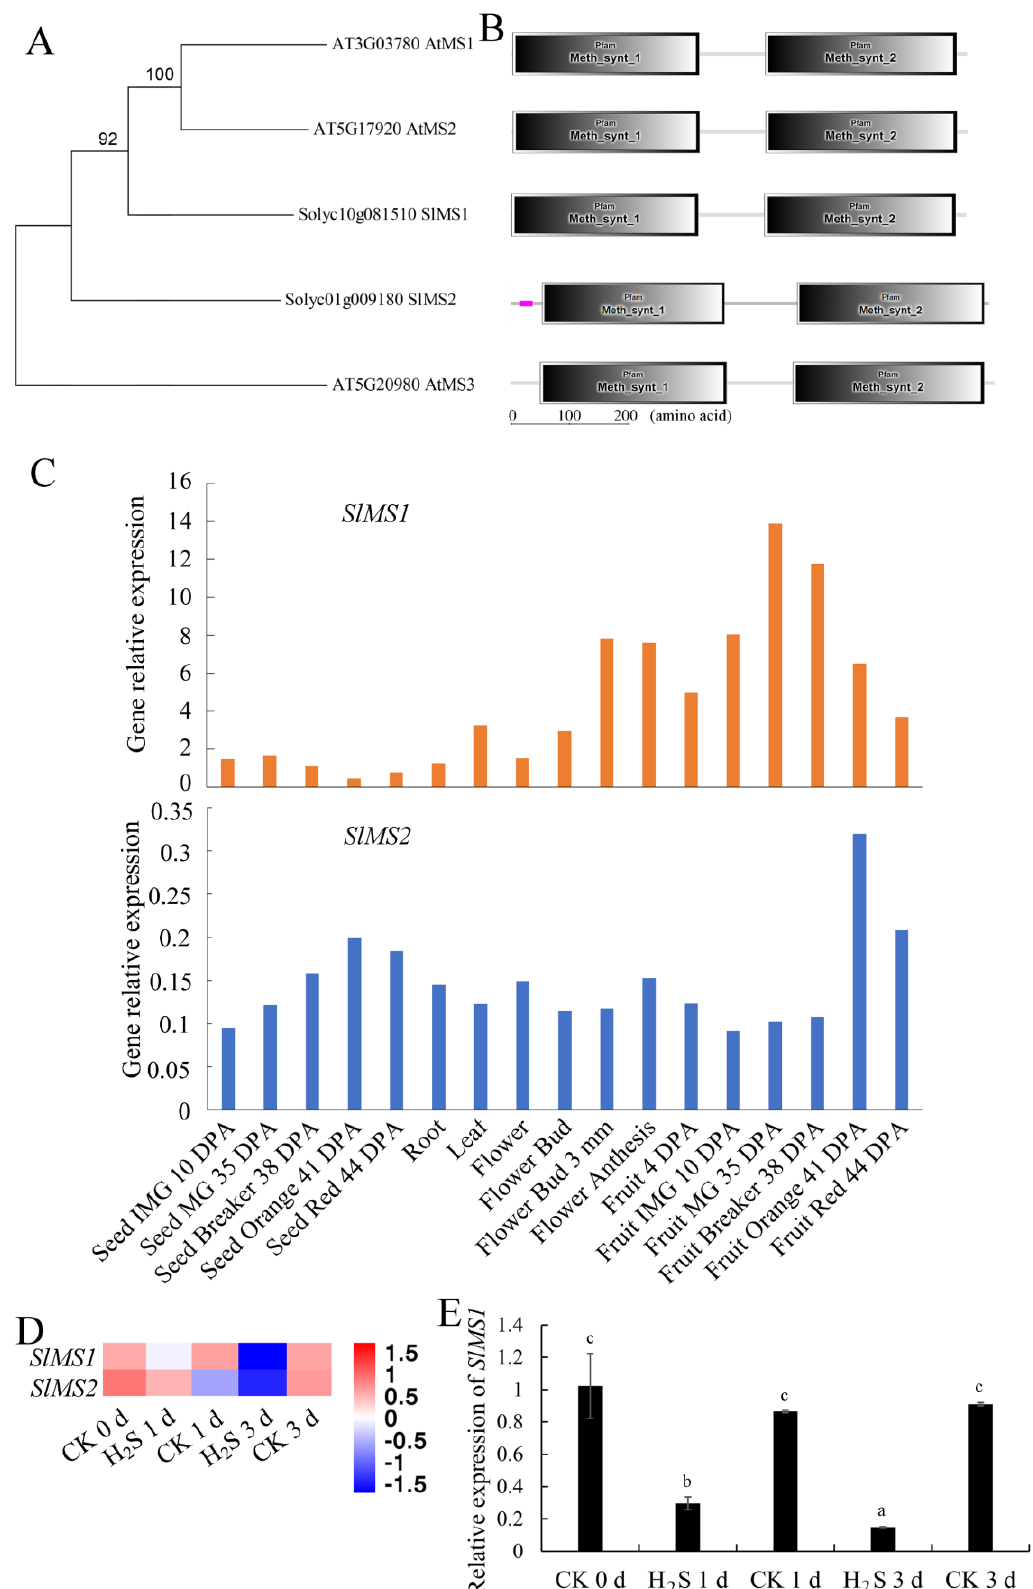
Figure 1. Phylogenetic analysis, domain construction and gene expression analysis for methionine synthases in Arabidopsis and tomato. ( A ) The neighbor-joining method was used to perform a phylogenetic analysis of methionine synthase in Arabidopsis and tomato based on a neighbor-joining